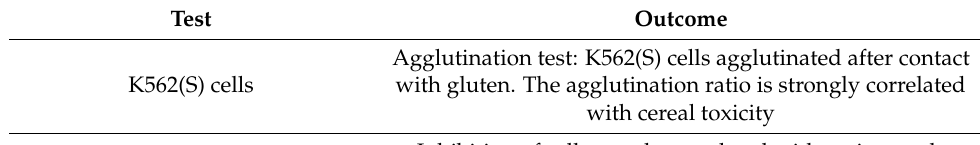
Table 2. In vitro and ex vivo tests most frequently used to evaluate the toxicity of cereals in